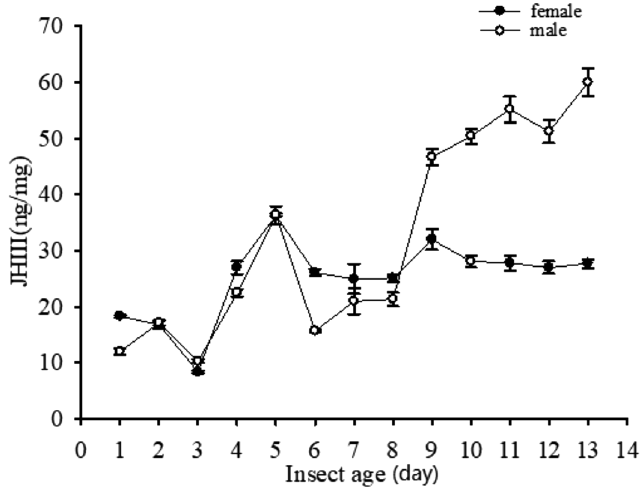
Figure 1. Changes in the juvenile hormone III (JHIII) titer in the absence of ultrasound in Monochamus alternatus adults. Each point represents the mean ± SE analyzed by HPLC and each HPLC measurement was repeated three times for a single sample to validate the analytical precision. Total number of M. alternatus adults across all three replicates: n =